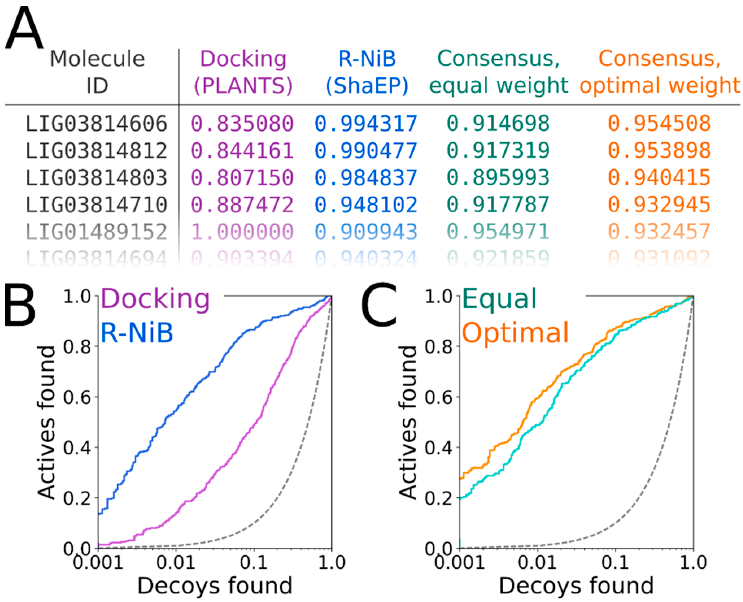
Figure 7. The consensus scoring of docking results using the negative image-based rescoring. ( A ) The highest PLANTS [17] scoring (magenta) and the ShaEP-based negative image-based rescoring (R-NiB) (blue) values for the docked DUD data set (both normalized from 0 to 1) are combined for the re-ranking of the compounds (green and orange). The aim was to improve the docking performance regarding the EFd 1% (Table 4) by applying either equal (weight = 0.50, green) or optimal weight (weight = 0.75, orange) on the scoring functions. The values are shown for the top-ranked molecules that were rescored using Model III (Figure 4H; Table 4). ( B ) Based on the semi-log10 scale (only x -axis logarithmic) receiver operating characteristics (ROC) curves, the straight-up R-NiB (weight = 1.00; Table 4; blue line) clearly outperforms the original docking scoring (magenta line; Table 4). ( C ) When a higher enrichment is sought via systematic re-weighting, the result is a consensus score with the optimal weight (orange line; Table 4) that produces higher early enrichment than the equal weight (green line; Table 4). Accordingly, relying more on the cavity-based ShaEP scoring than the original PLANTS docking or ChemPLP scoring produces a better yield. See Figure 1 for interpretation.